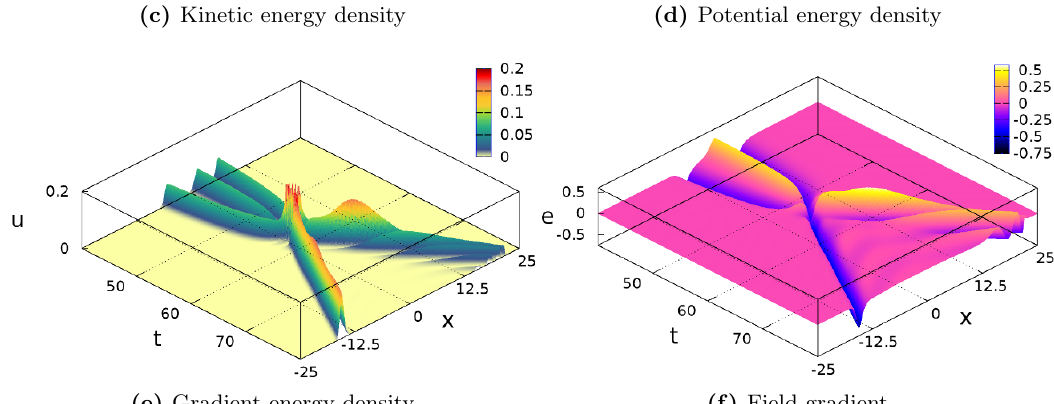
of the central kink 2